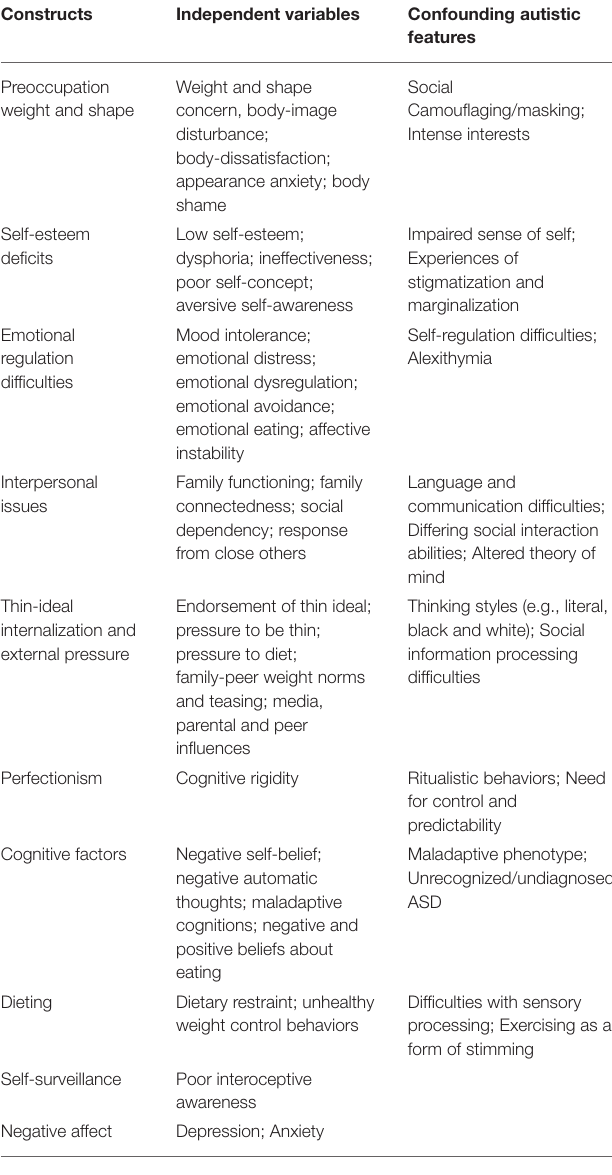
TABLE 1 | A list of the main existing constructs and independent variables of disordered eating as summarized by Pennesi and Wade (2016, p. 184) and confounding autistic